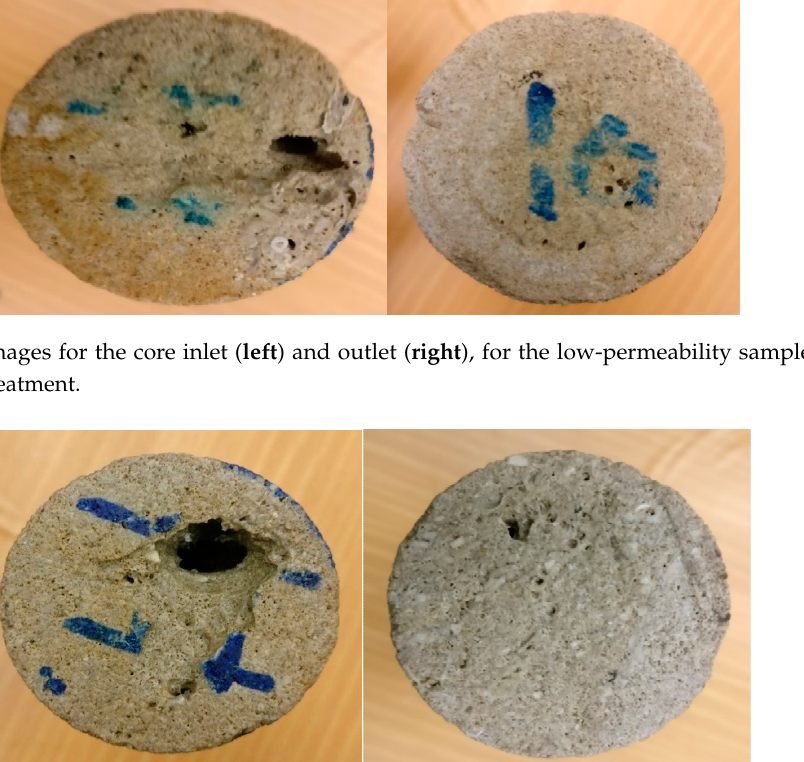
Figure 11. Images for the core inlet ( left ) and outlet ( right ) for the high- permeability sample after thermochemical / HCl treatment.